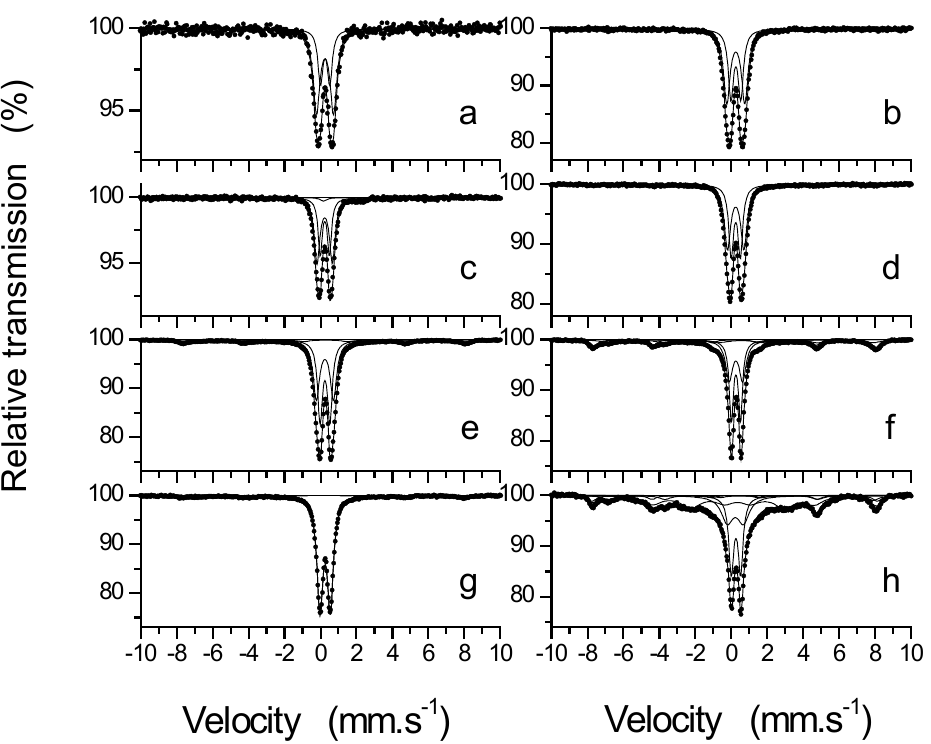
Figure 8. Mossbauer spectra of biogenic materials obtained in different feeding media: a - Hay, b – Winogradsky, c – Lieske, d - ISSL, g – ISSLk, e - Adler, f – AdlerK, h –